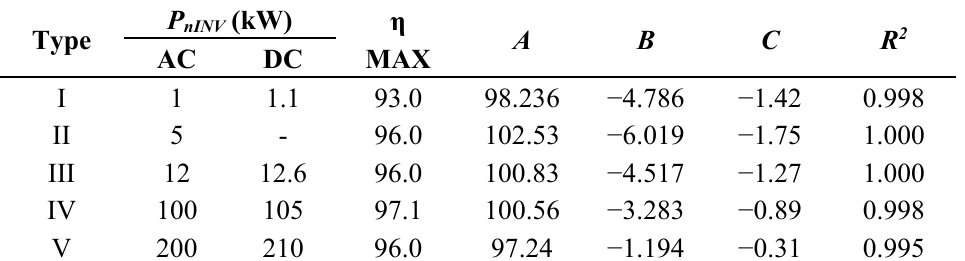
Table 2. Some inverter specifications found in the commercial PVsyst database and A , B , C and R 2 coefficients calculated for the same